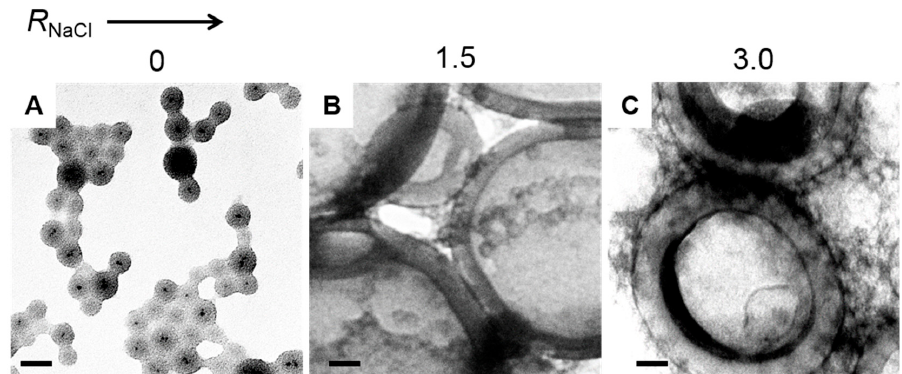
Figure 5. Effect of added salt content on self-assembly of PS/PMAA-CdS nanoparticles in THF/water mixtures. For all three preparations, c 0 = 0.25 wt %: ( A ) R NaCl = 0 (no salt added), ( B ) R NaCl = 1.5, and (C) R NaCl = 3.0. All scale bars are 50 nm.